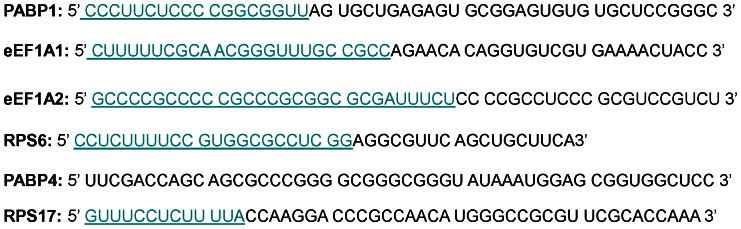
Nucleotide sequence of the 5′ end of different mRNA.Sequences were obtained from the NCBI database The TOP cis elements are highlighted. The 5′ ends of PABP1, eEF1A1, eEF1A2, RPS6 and RPS17 are shown. Note that both RPS17 and eEF1A2 TOP elements contain a terminal G instead of a terminal C present in PABP1, EEF1A1 and RPS6 mRNAs.